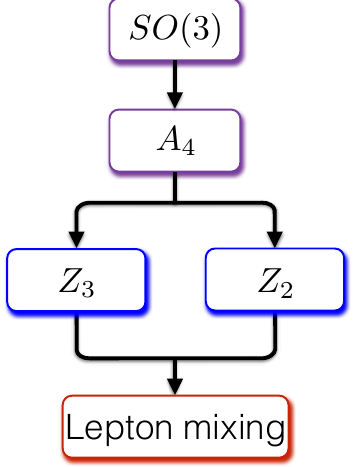
Figure 2 . A sketch of the symmetry breaking in the model and how (cid:13)avour mixing is generated. The (cid:13)avour symmetry at high energy is assumed to be supersymmetric SO(3). It is broken (cid:12)rst to A 4 , which then breaks, at a lower scale, to the residual symmetry Z 3 in the charged lepton sector and Z 2 in the neutrino sector, with supersymmetry preserved throughout. The misalignment of the residual symmetries gives rise to (cid:13)avour